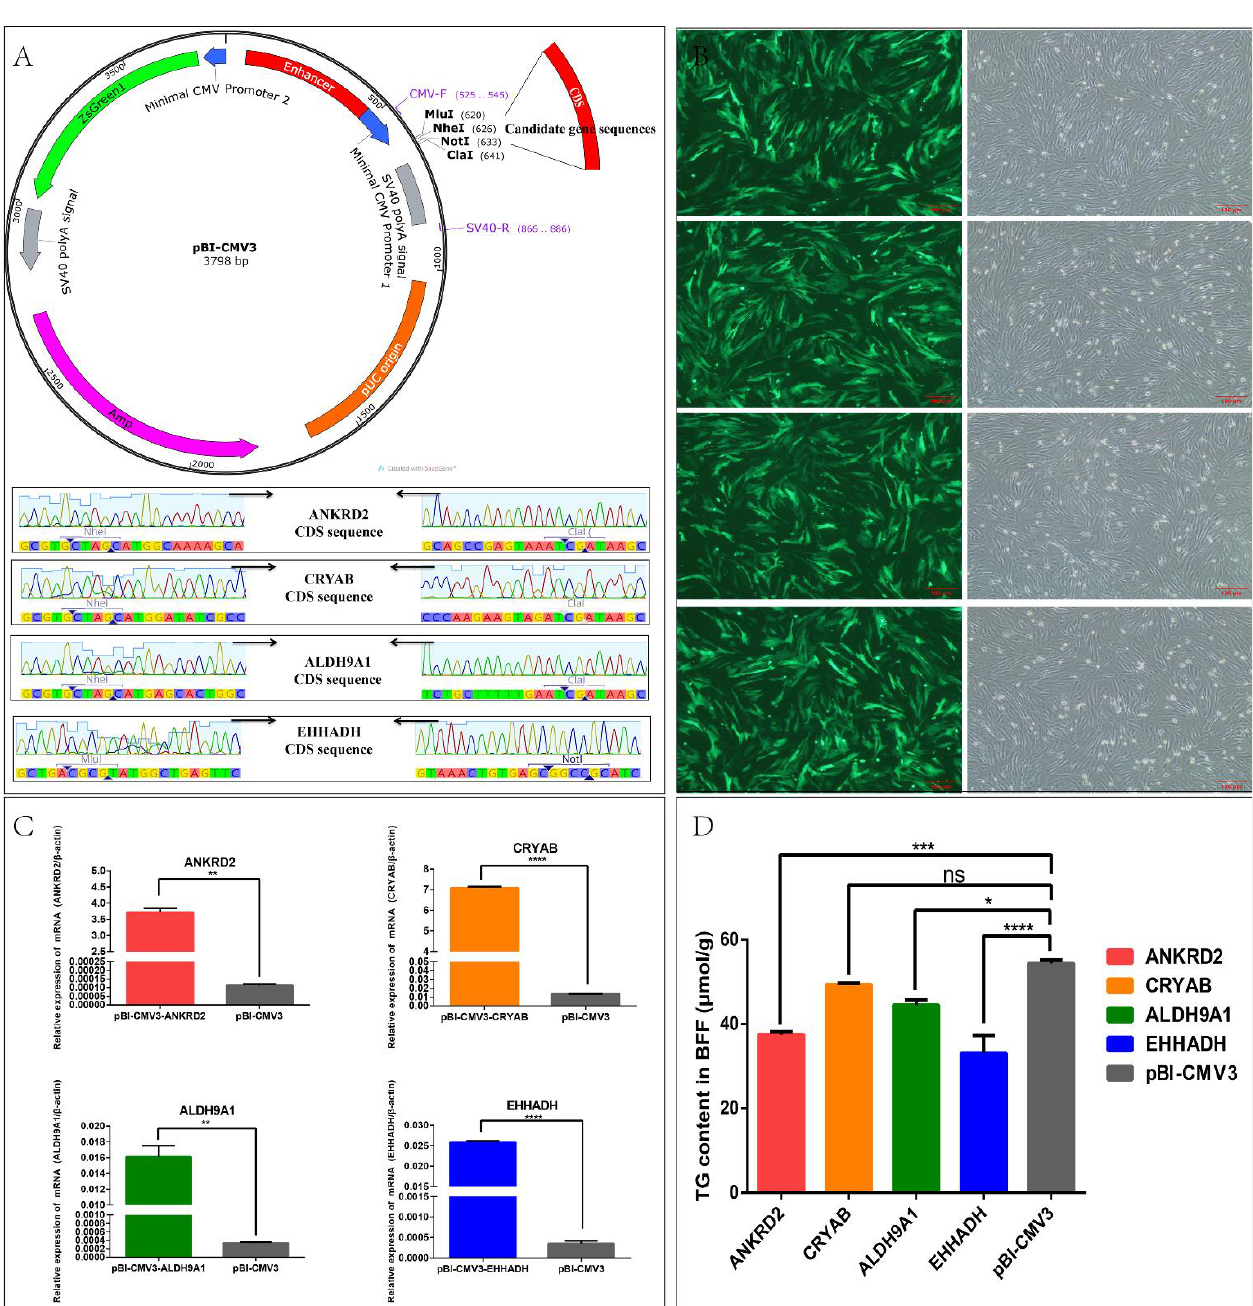
Figure 3. Construction of candidate gene overexpression vectors and their effects on triglyceride content in bovine fetal fibroblasts (BFFs). ( A ) The coding sequence (CDS) of the candidate gene was amplified by PCR and ligated to the pBI-CMV3 vector; ( B ) green fluorescent protein expression of BFFs 48 h after transfection; ( C ) RT-qPCR to detect mRNA levels of candidate genes; ( D ) detection of triglyceride content in BFFs. * p < 0.05, ** p < 0.01, *** p < 0.001, **** p < 0.0001 . Detection of intracellular triglyceride showed that the overexpression of ANKRD2 , ALDH9A1 and EHHADH resulted in significant decreases in the intracellular triglycerides ( p < 0.01). We found the most pronounced decrease after the overexpression of EHHADH (33.132 ± 4.12 7 μmol/g). Overexpression of CRYAB in BFFs also lowered intracellular tri- glycerides (49.326 ± 0 .341 μmol/g) , whereas there was no significant difference between the pBI-CMV3-CRYAB and pBI-CMV3 groups (54.387 ± 0 .791 μmol/g , Figure 3D). These